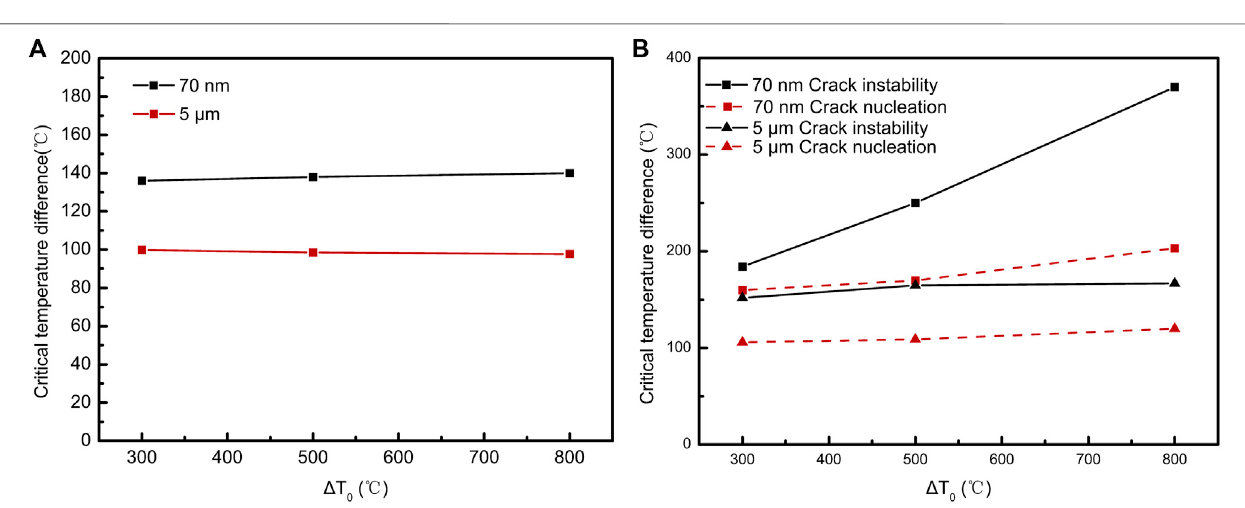
FIGURE9| (A) Critical stresstemperature differenceofthe70-nm model and 5- μ m model at different T 0 ; (B) temperaturedifference ofcrack nucleationand crack instability of the 70-nm model and 5- μ m model at different T 0 .